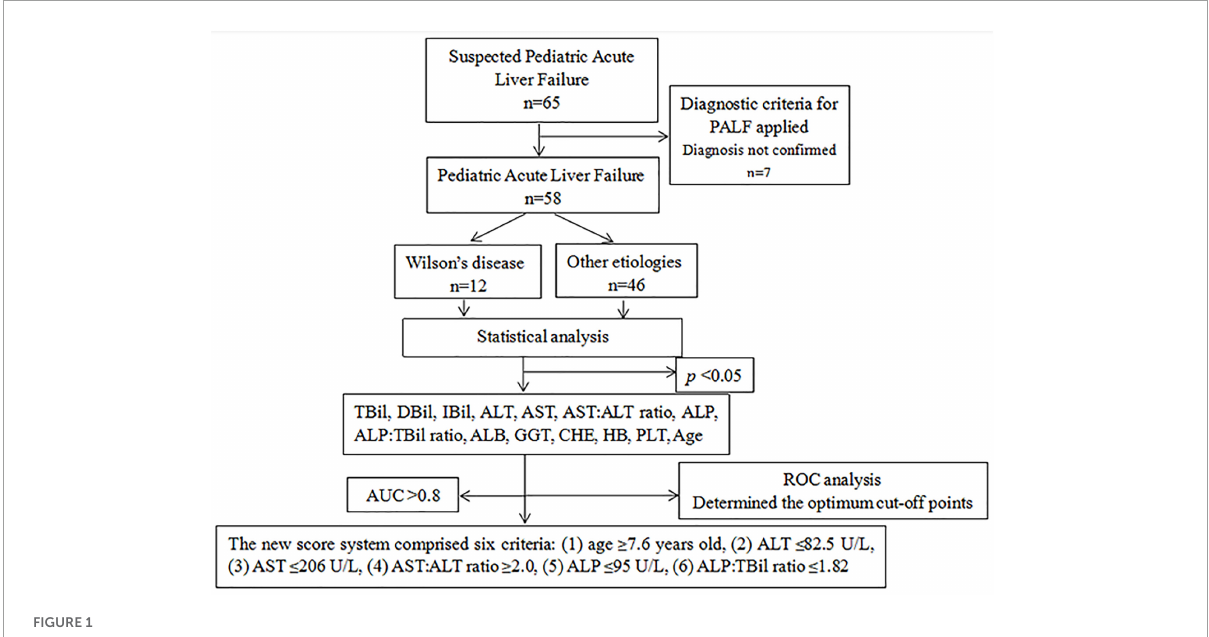
FIGURE1 Flow diagram depicting the formation of the new scoring system.